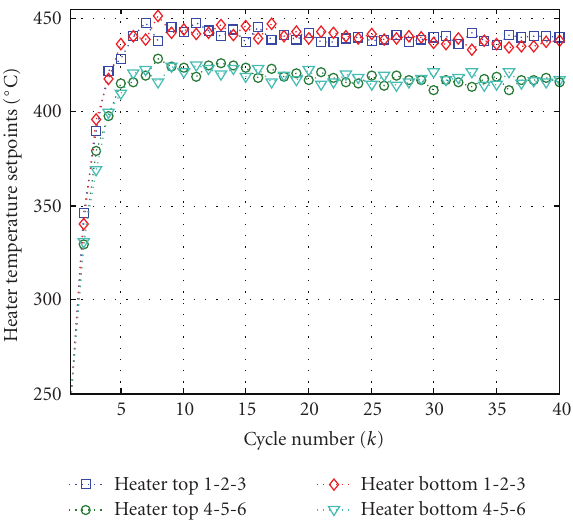
Figure 6: Heater temperature setpoints (1st